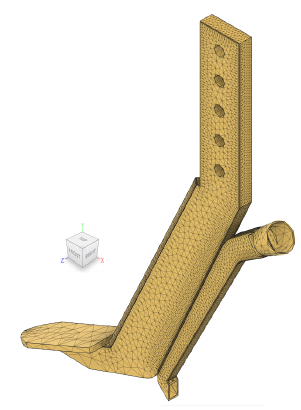
Figure 7: Finite element model and meshing construction of the DPFA